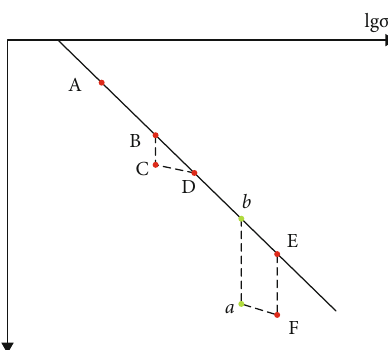
Figure 8: Description